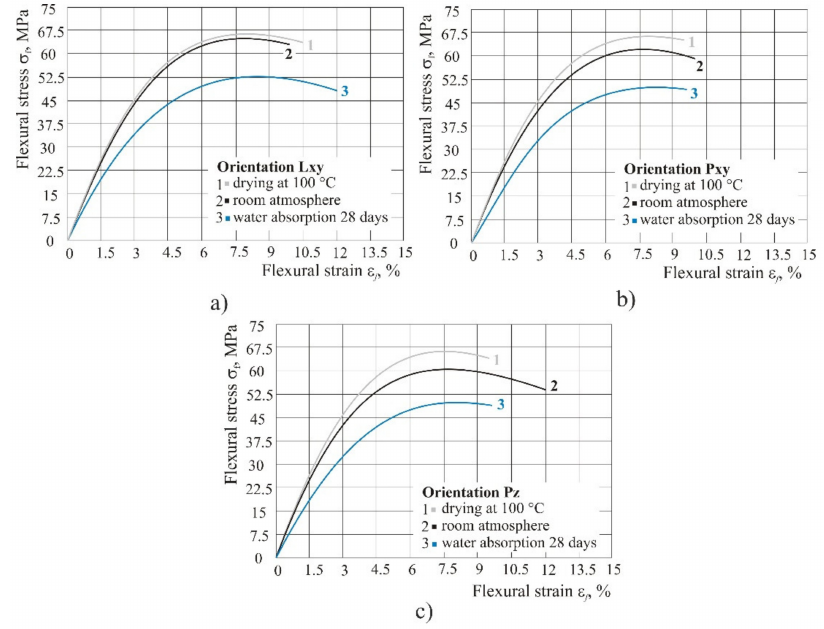
Figure 11. Comparison of different atmospheric conditions (dry, normal and 100% humid atmo- sphere): ( a ) orientation Lxy, ( b ) orientation Pxy, ( c ) orientation Pz.